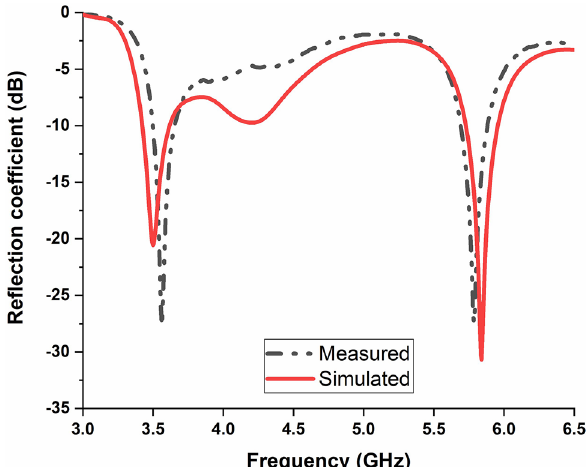
Figure 16. Simulated and measured reflection coefficient.